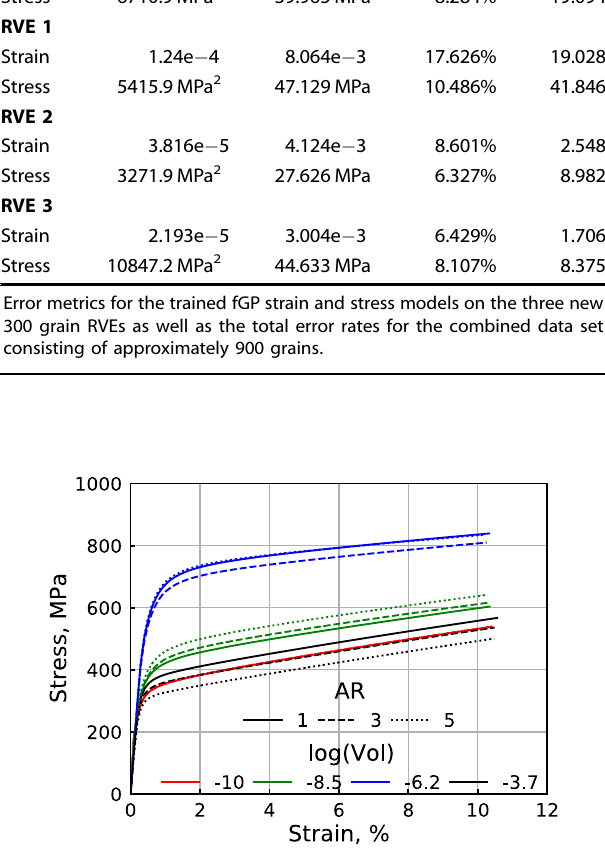
Fig. 6 Grain size and shape analysis. Stress – strain data from the fGP graphical network for the 200 grain “ microstructures ” generated via specifying a grain size and shape distribution. AR average aspect ratio, log(Vol) logarithm of the average grain